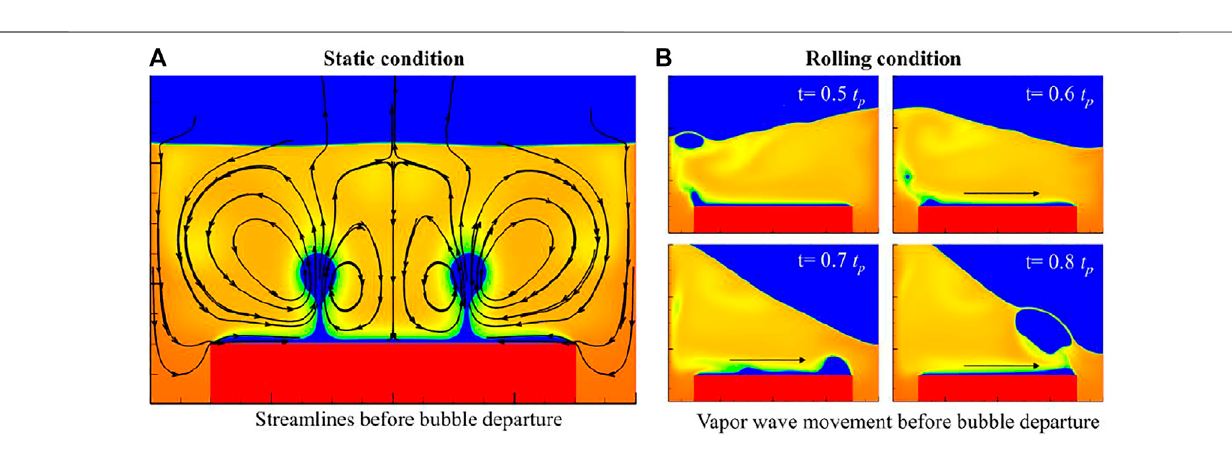
Frontiers in Energy Research |